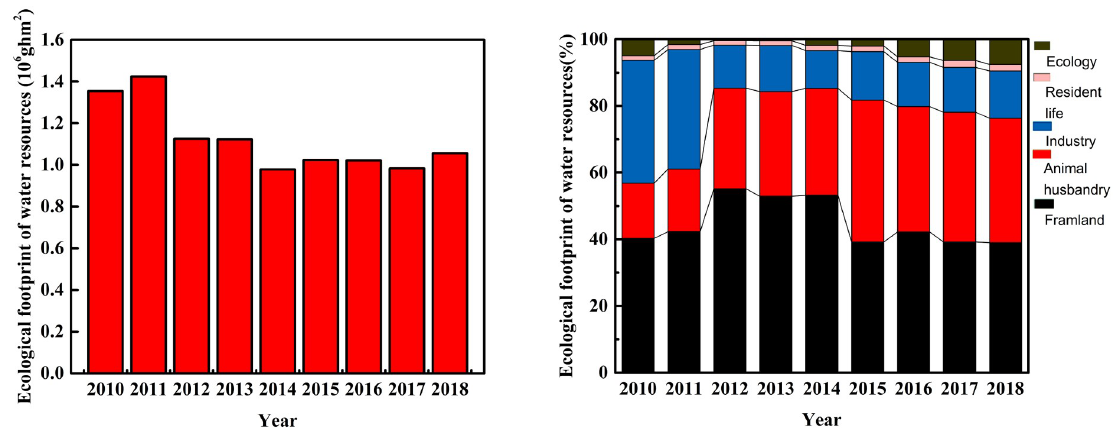
Fig 6. Ecological footprint of water resources (left) and the proportion of different water consumption (right) in the study area.